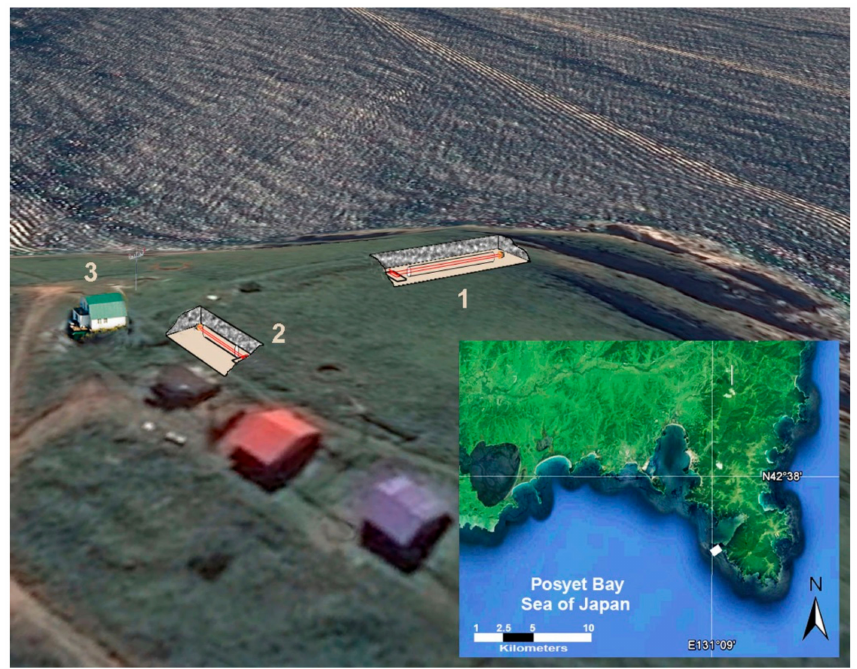
Figure 3. Number 1 is the 52.5-meter laser strainmeter, 2—17.5-meter laser strainmeter. 3—laboratory